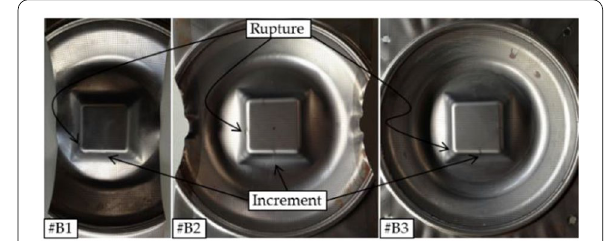
Figure 14 Samples formed through hybrid